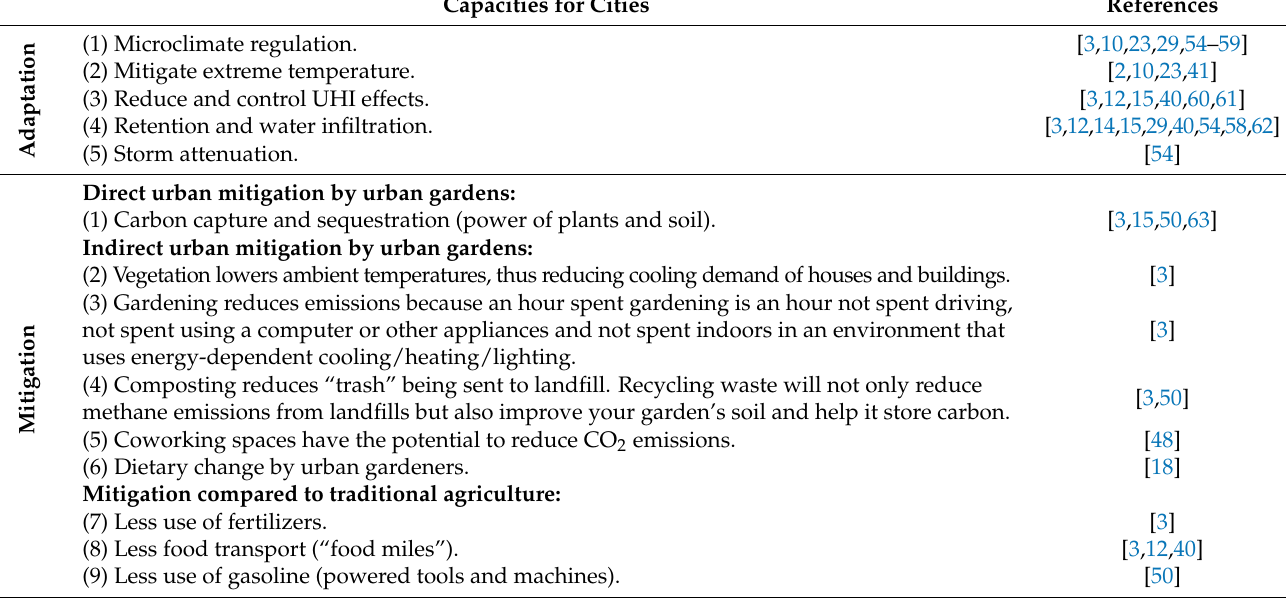
Table 4. Adaptation, mitigation and resilience capacities provided by urban gardens for cities. Capacities for